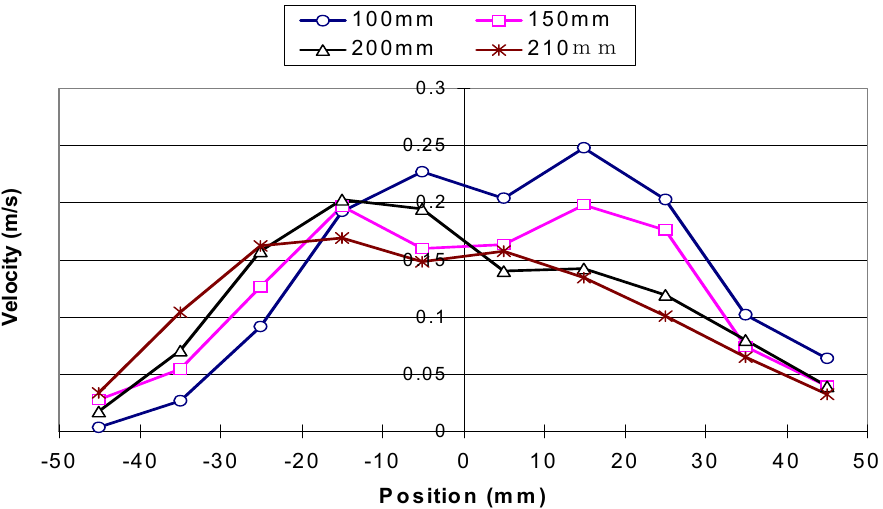
Fig. 10 : X-direction velocity for 0-degree position and without fire-tube